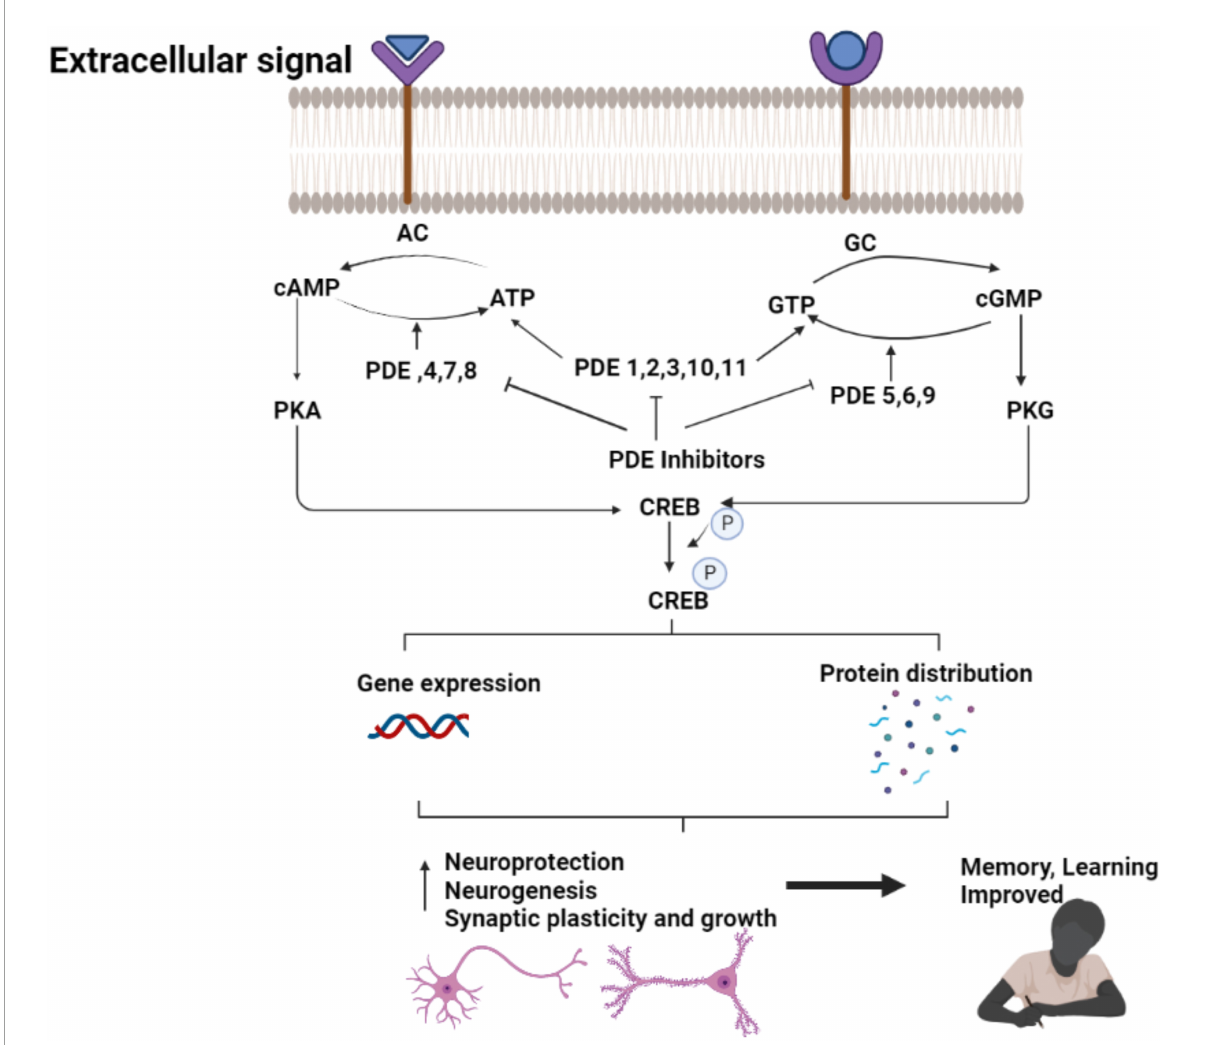
FIGURE3 Therapeutic effect of PDE inhibitors in AD. The figure is original and generated by Bio-render